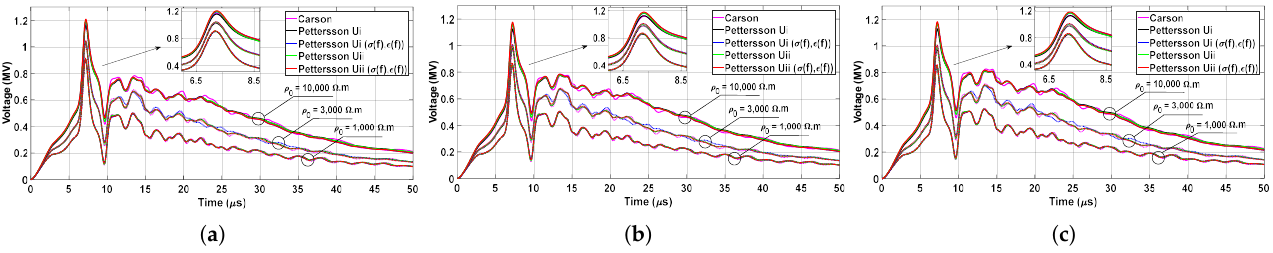
Figure 11. Overvoltage waveforms in phases A ( a ), B ( b ) and C ( c ), with or without a disruption process (backflashover), considering a lightning stroke current waveform with α = 1.99, and ground resistivities equal to 1000 Ω .m, 3000 Ω .m and 10,000 Ω